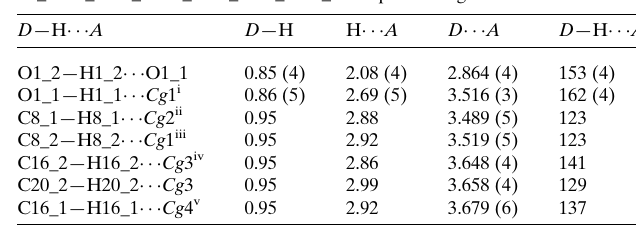
Table 1 Hydrogen-bond geometry (A˚ , (cid:3) ).